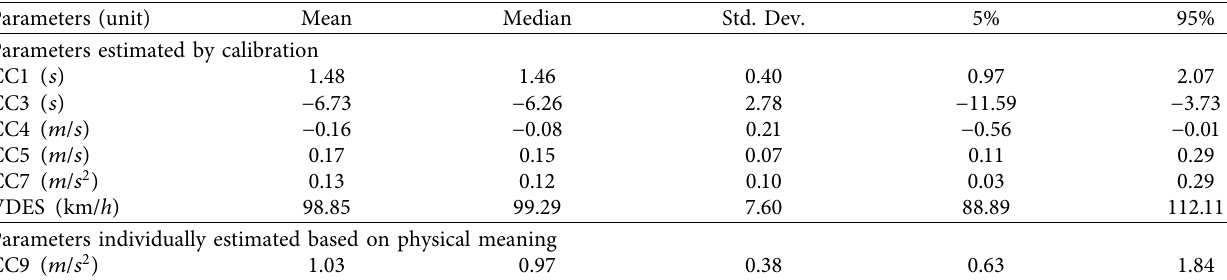
Table 10: Estimated parameters from Wiedemann 99 car-following model for Lv2